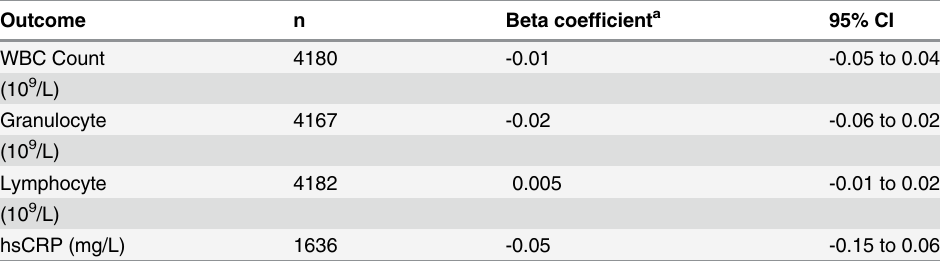
Table 2. Effect of genetically predicted testosterone on markers of systemic inflammation among 4182 and a subgroup of 1636 men (50+) in a Mendelian randomization study design, Guangzhou Bio- bank Cohort Study, 2003 –